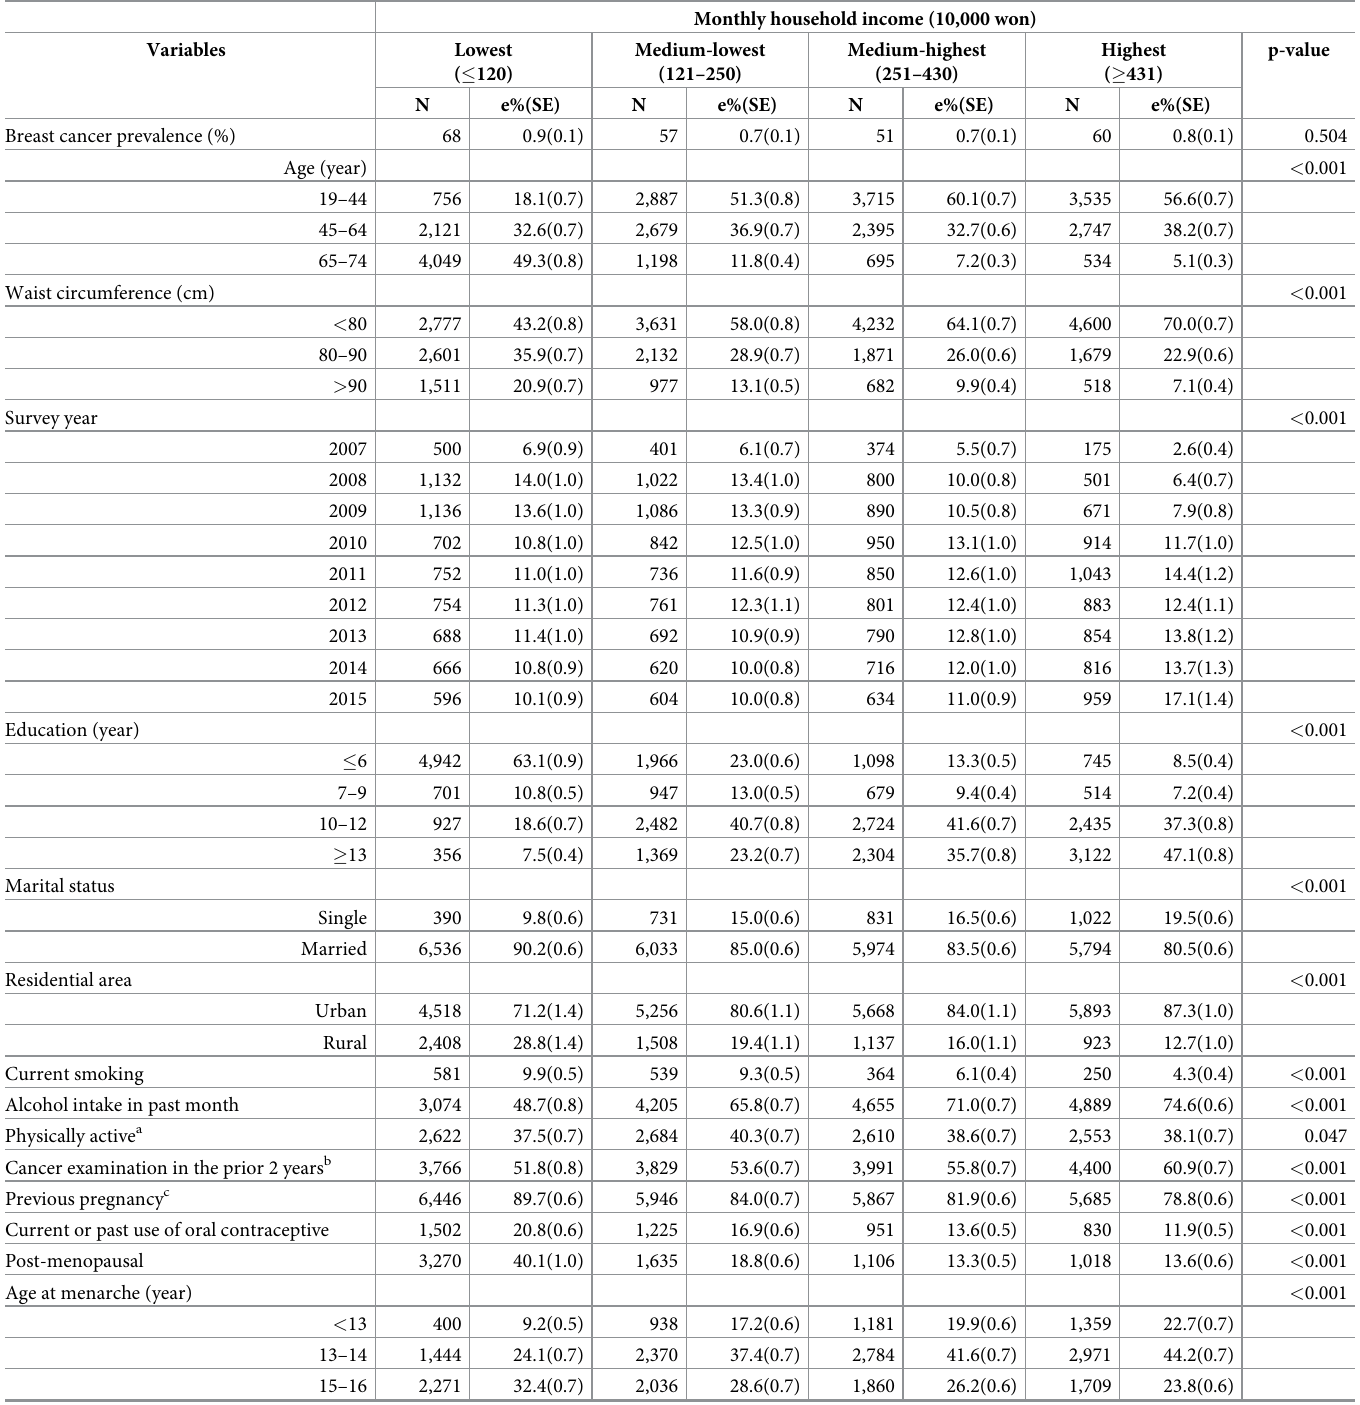
Table 2. Characteristics of subjects by quartile of monthly household